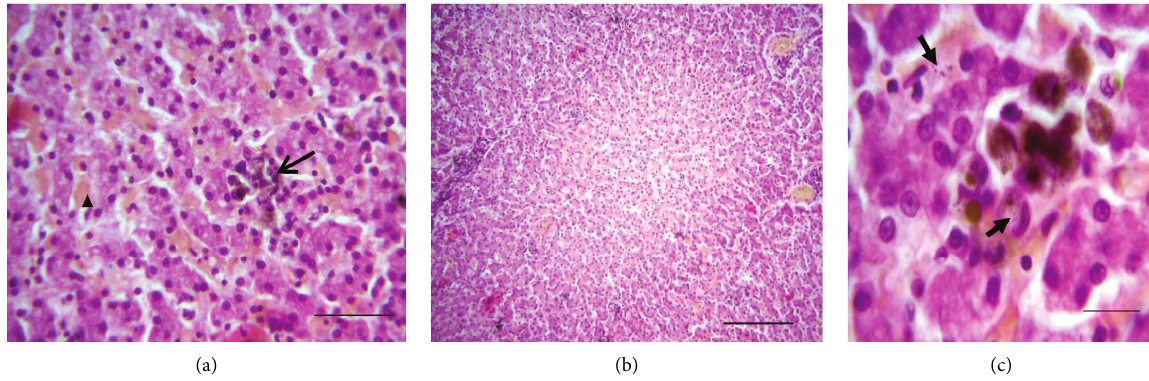
Figure 4: Histologicsections ofthe liver ofa Leishmania -positive dog.(a) Moderate congestionofsinusoid capillaries(arrowheads). Agglomerate of hyperplastic Kupffer cells (arrow) showing hemosiderin phagocytosis in sinusoid capillaries, H&E, bar � 90 µ m. (b) Moderate centrilobular passive congestions, H&E, bar � 200 µ m. (c) Multiple intracytoplasmic bluish inclusions of Leishmania spp. amastigotes (arrows) within Kupffer cells. H&E, bar � 40 µ